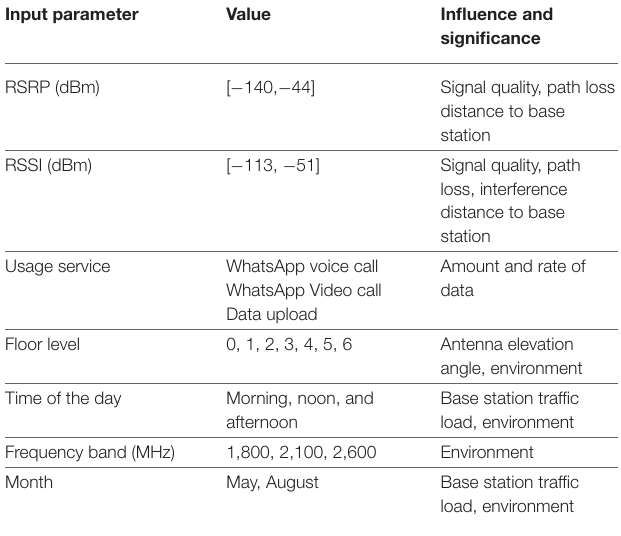
TABLE 1 | Input parameters of ANN.